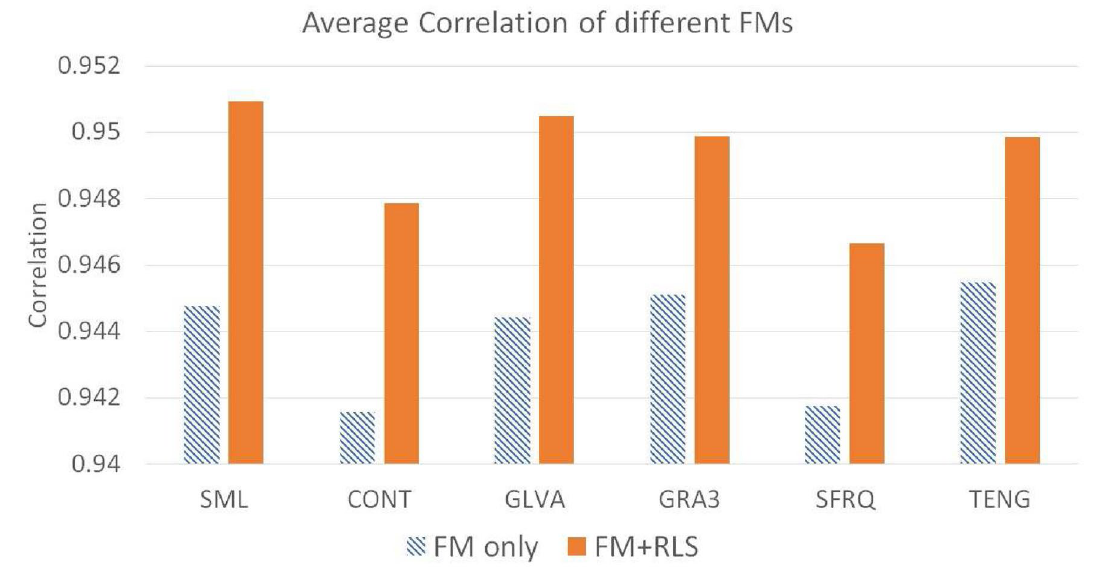
b ) 2 σ 2 2 a 2 σ 4 ( 2 ak ζ + ζ with = +